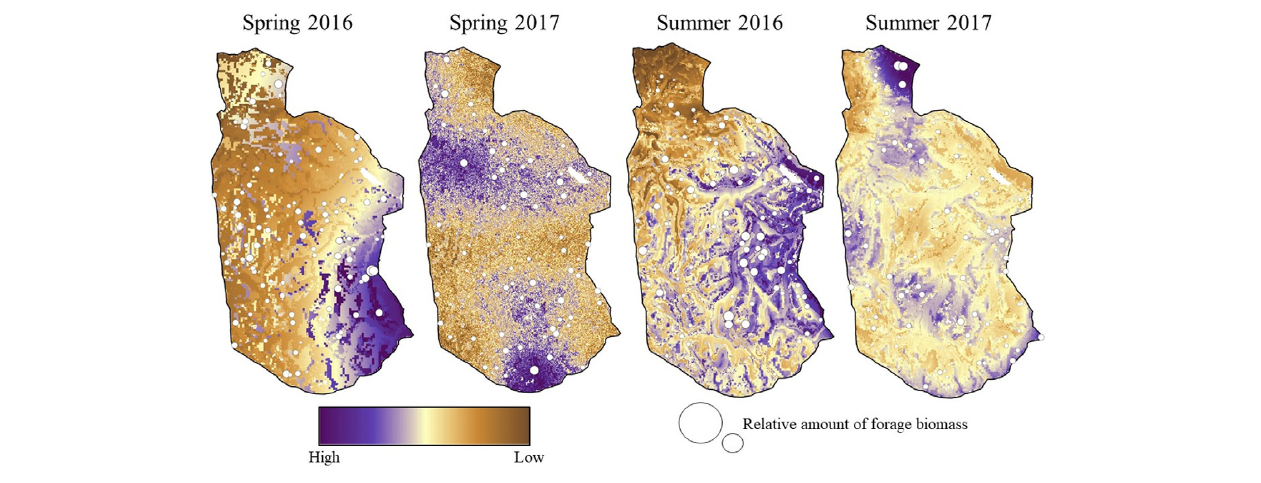
FIGURE 1 | Predicted spatiotemporal variation in the nutritional landscape (biomass of selected and neutral forage plants) available to mule deer during a representative week in mid-spring (29 May–5 June) and mid-summer (15–22 July), 2016 and 2017, at the Starkey Experimental Forest and Range, Oregon, United